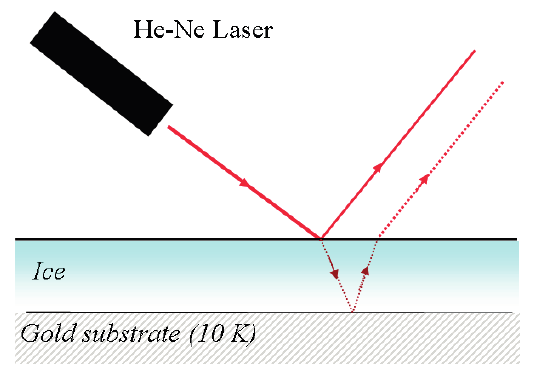
Figure 4. Diagram of single laser interference-based thickness measurement process for transparent